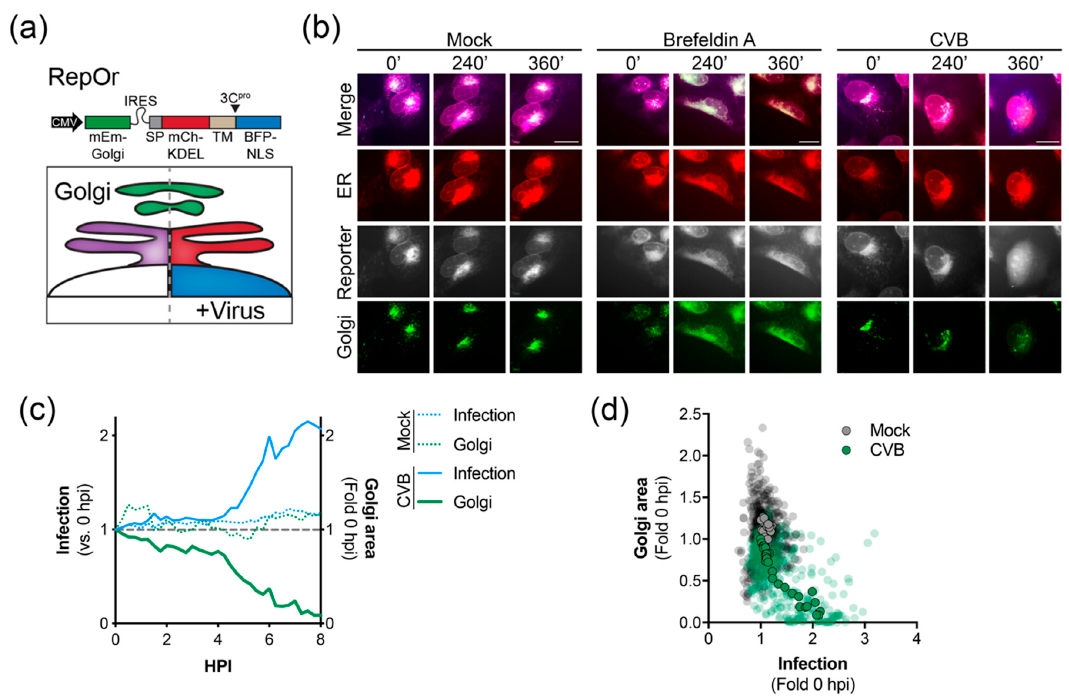
Figure 3. Time-lapse imaging of CVB infected cells expressing RepOr. ( a ) Top , the bicistronic RepOr cassette contains a Golgi localized mEmerald (mEm-Golgi) followed by an IRES-driven RepER, where the GFP has been substituted with BFP. Signal peptide (SP), transmembrane domain (TM), and nuclear localization signal (NLS). Bottom , Schematic of the predicted model for visualizing the Golgi, ER, and enterovirus infection. In uninfected cells (left), mCherry and BFP colocalize in the ER (purple), and mEmerald is localized to the Golgi (green). During enterovirus infection (right), viral 3C pro cleavage releases the BFP-NLS, which translocates to the nucleus, the mCherry is retained in the ER (red) and the Golgi remains (green). ( b ) Representative time-points of an image series from live-cell imaging of mEmerald (Golgi, green), BFP (reporter, gray), mCherry (ER, red), and merged panels from U2OS cells expressing RepOr treated with DMSO, brefeldin A, or infected with CVB. Scale bars are 20 µ m. ( c ) Quantification of infection (blue) and Golgi area (green) in mock (dashed lines, n = 16) and CVB (solid lines, n = 16) infected cells shown as the average fold change compared to 0 hpi; the gray dashed line shows a fold change of 1. ( d ) Scatter plot of infection and Golgi areas. Transparent dots represent individual measurements taken every 15 min for individual mock (gray, n = 16) or CVB (green, n = 16) infected cells from 0 to 6 hpi, solid outlined dots represent the averages.